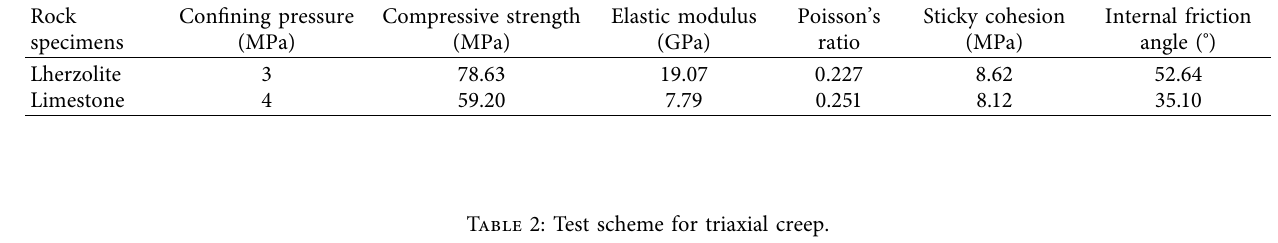
Table 1: Basic parameters of the rock specimens.